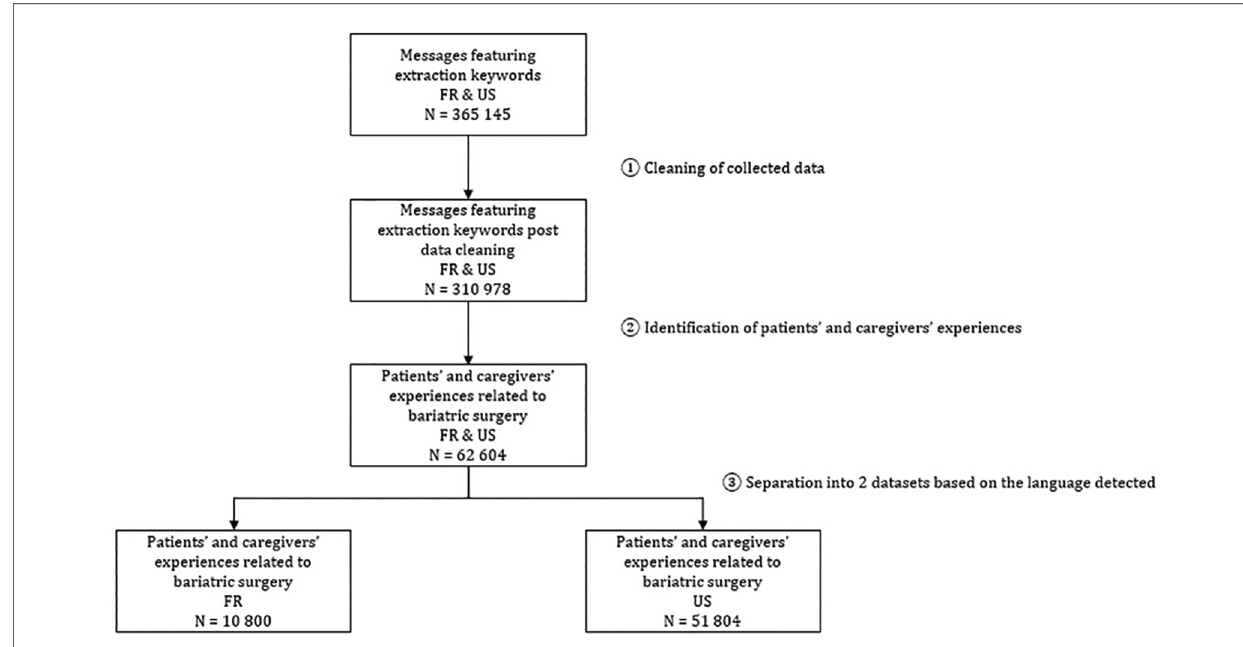
FIGURE 1 Flowchart presenting posts extraction from social media geolocated in France and the